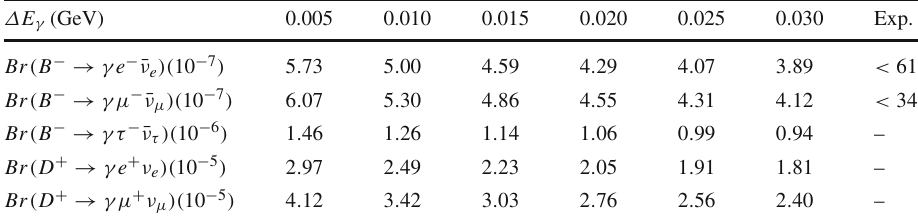
fractions of the decays B − → γ l − ¯ ν l ( l = e ,μ,τ) and D + → γ l + ν l ( l = e ,μ) in the SM and corresponding experimental upper limits